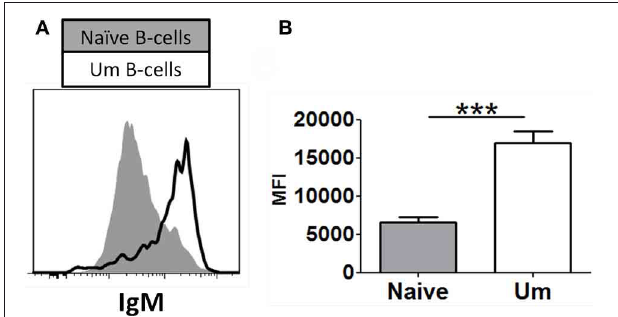
FIGURE 2 | Naïve and Um B cells show different frequency of IgM molecules on the cell surface. Um B cells (black line histogram) show a higher IgM mean fluorescence intensity (MFI) on their surface than naïve B cells (gray closed histogram) as shown in this representative volunteer (A) . Compiled data from 8 healthy adults (B) . ∗∗∗ p = 0 . 0001.